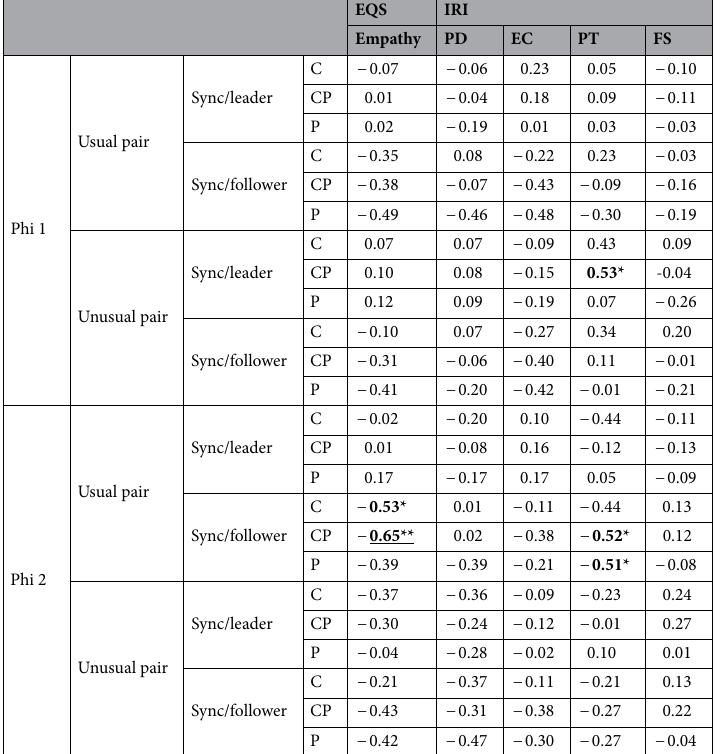
Table 1. Correlations between the phi complex and the scores of questionnaires. The r values of the correlational analyses are shown. Bolded values indicate significance before applying the false discovery rate (FDR) correction. Underlined values indicate the correlation which reached a marginal significance after applying the FDR correction. * p < .05; ** p < .001 (in the correlation without the FDR correction).